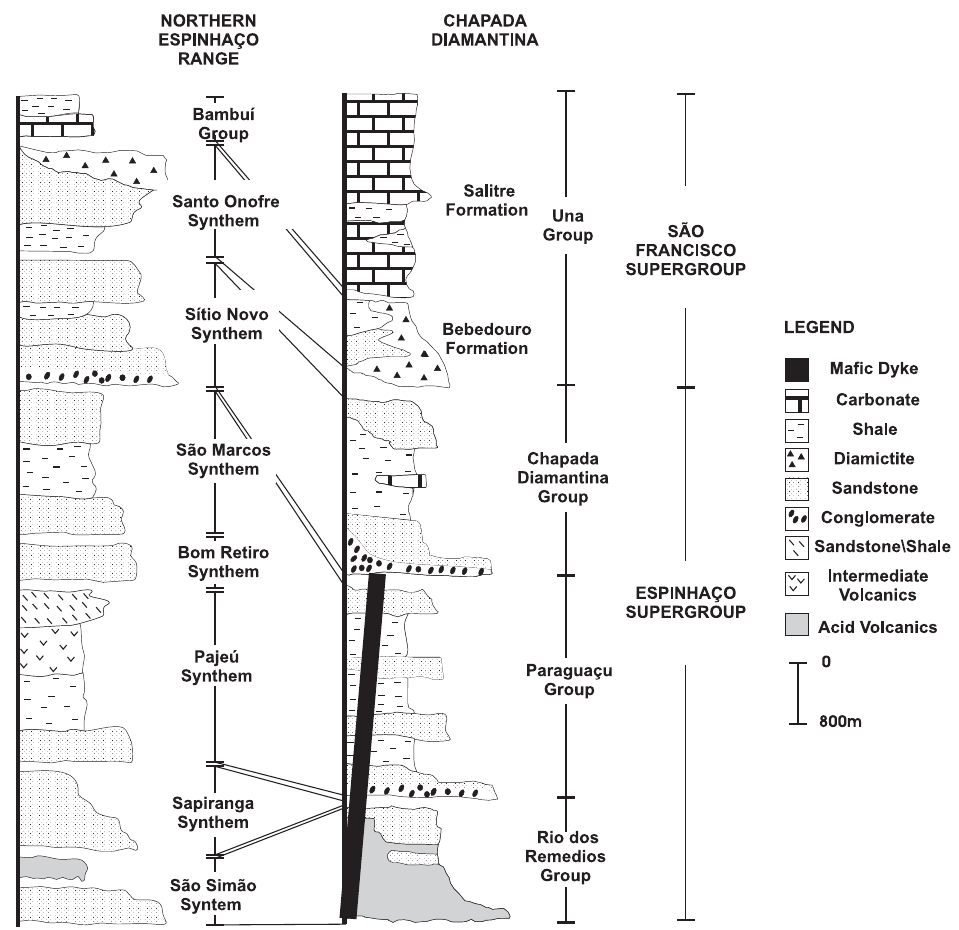
Fig. 3 – Schematic stratigraphic columns for the Chapada Dimantina and northern Espinhaço range ◦ , unpublished (Based on A. Danderfer F